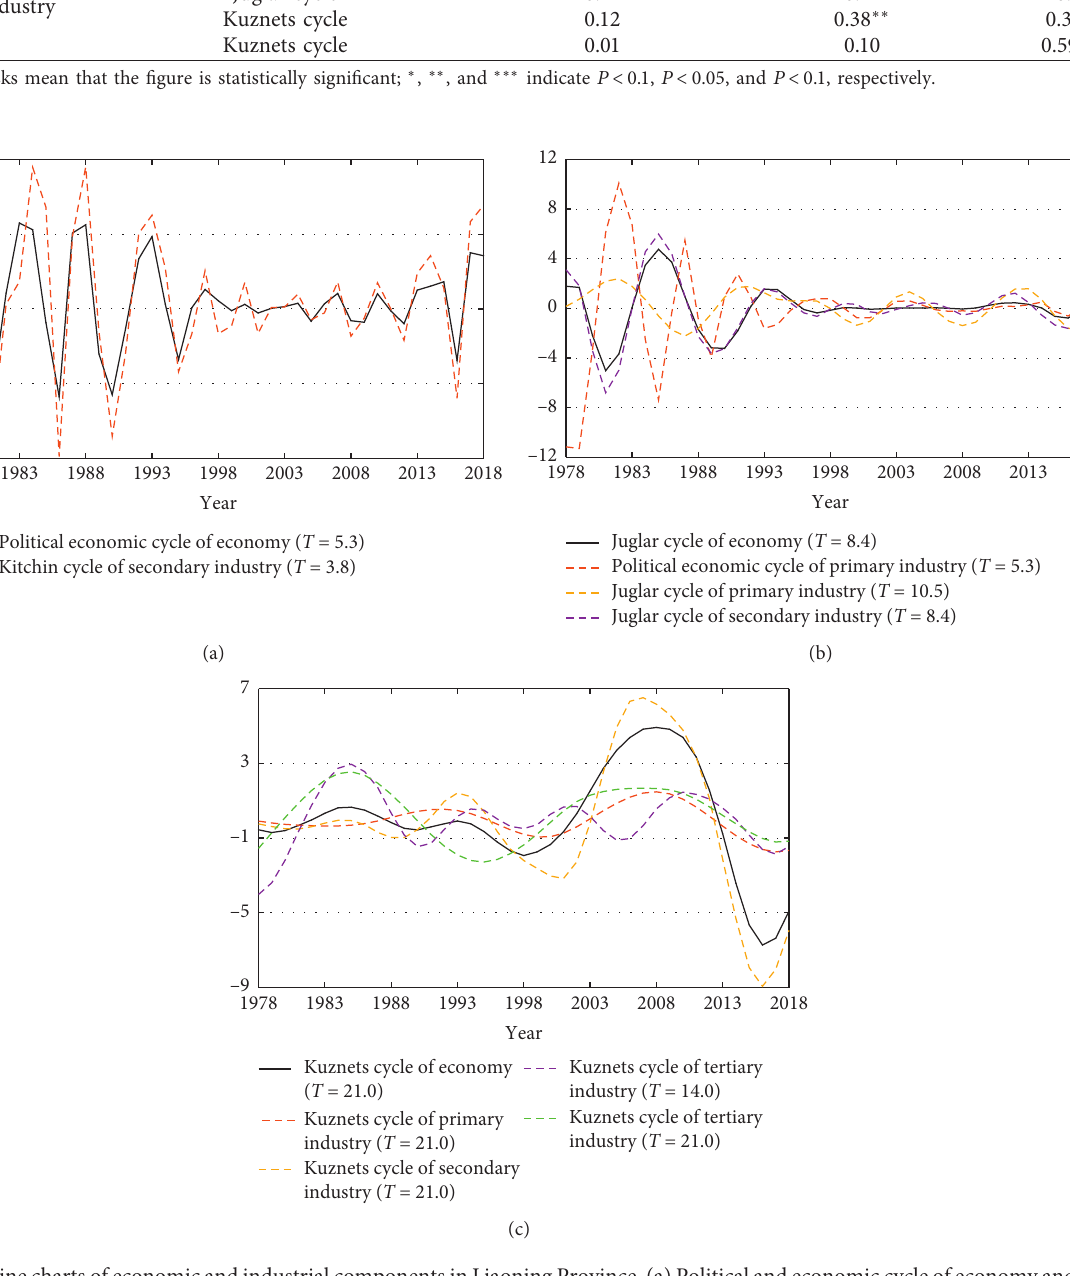
Figure 5: Line charts of economic and industrial components in Liaoning Province. (a) Political and economic cycle of economy and related industry components. (b) Juglar cycle of economy and related industry components. (c) Kuznets cycle of economy and related industry